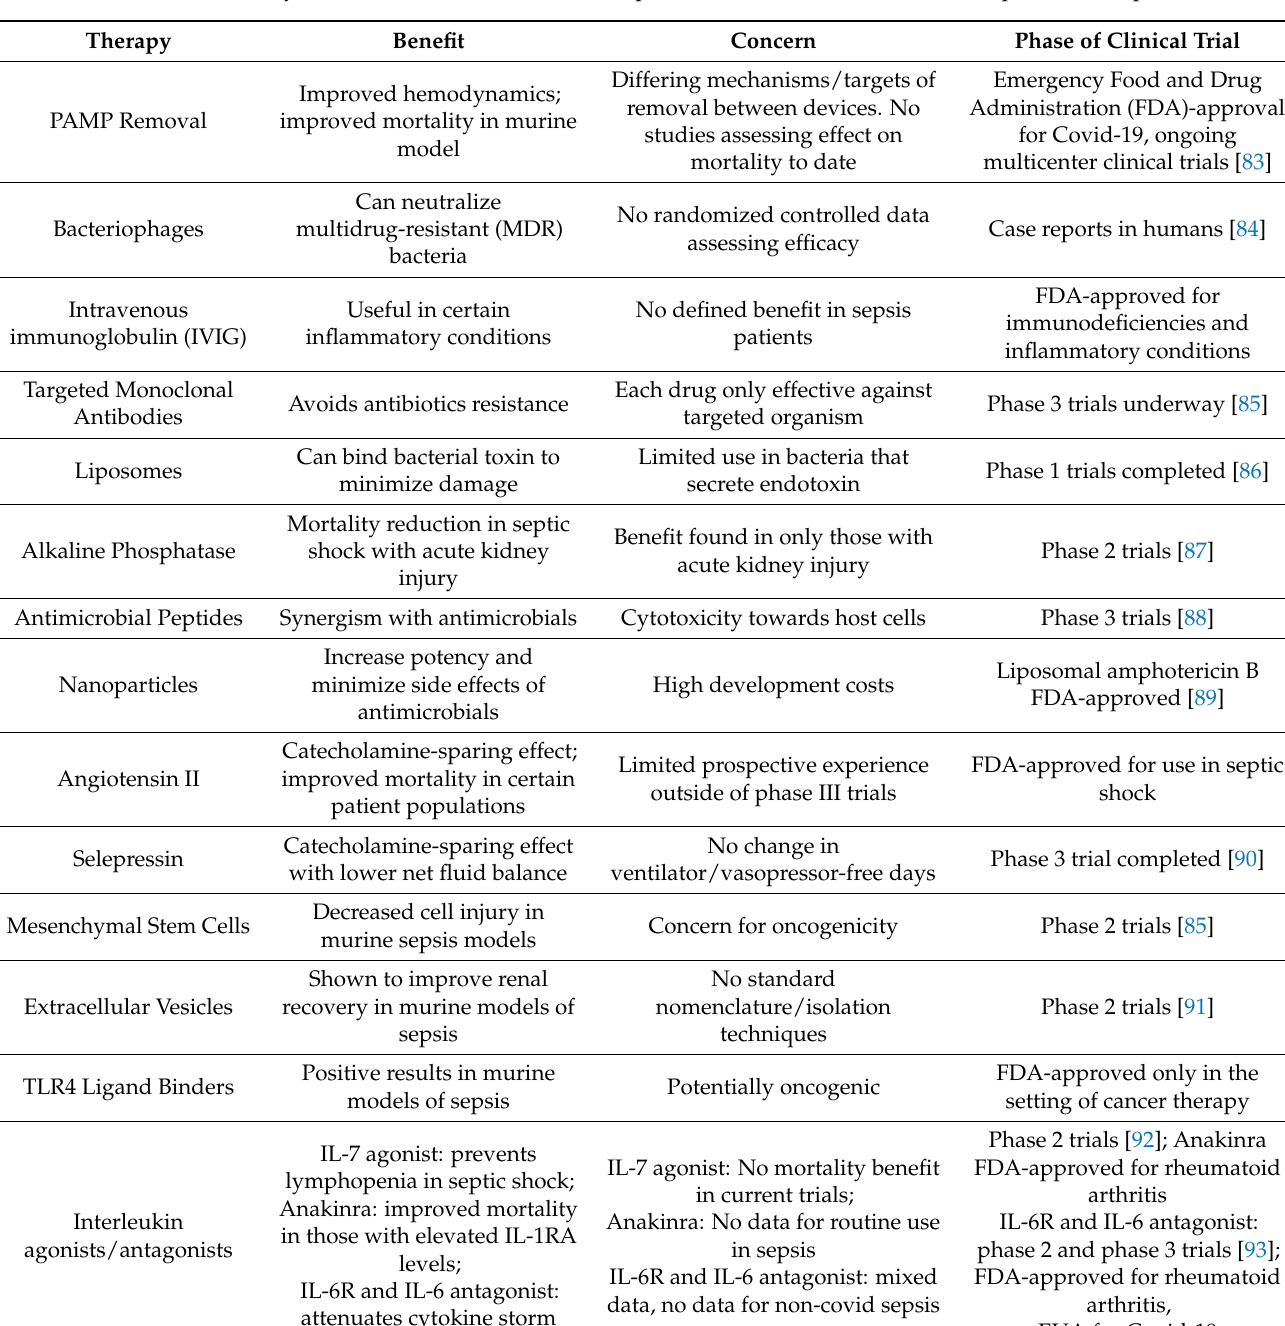
Table 2. Summary of benefits, concerns, and current phase of clinical trials for novel therapeutics for sepsis.